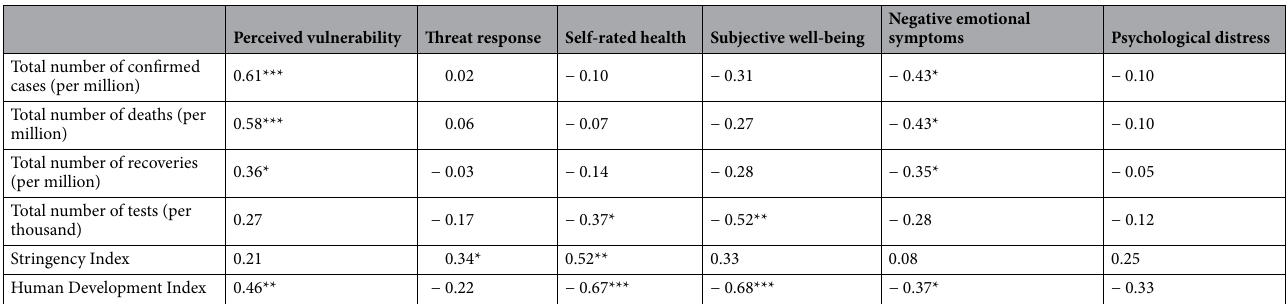
Negative emotional symptoms Psychological distress